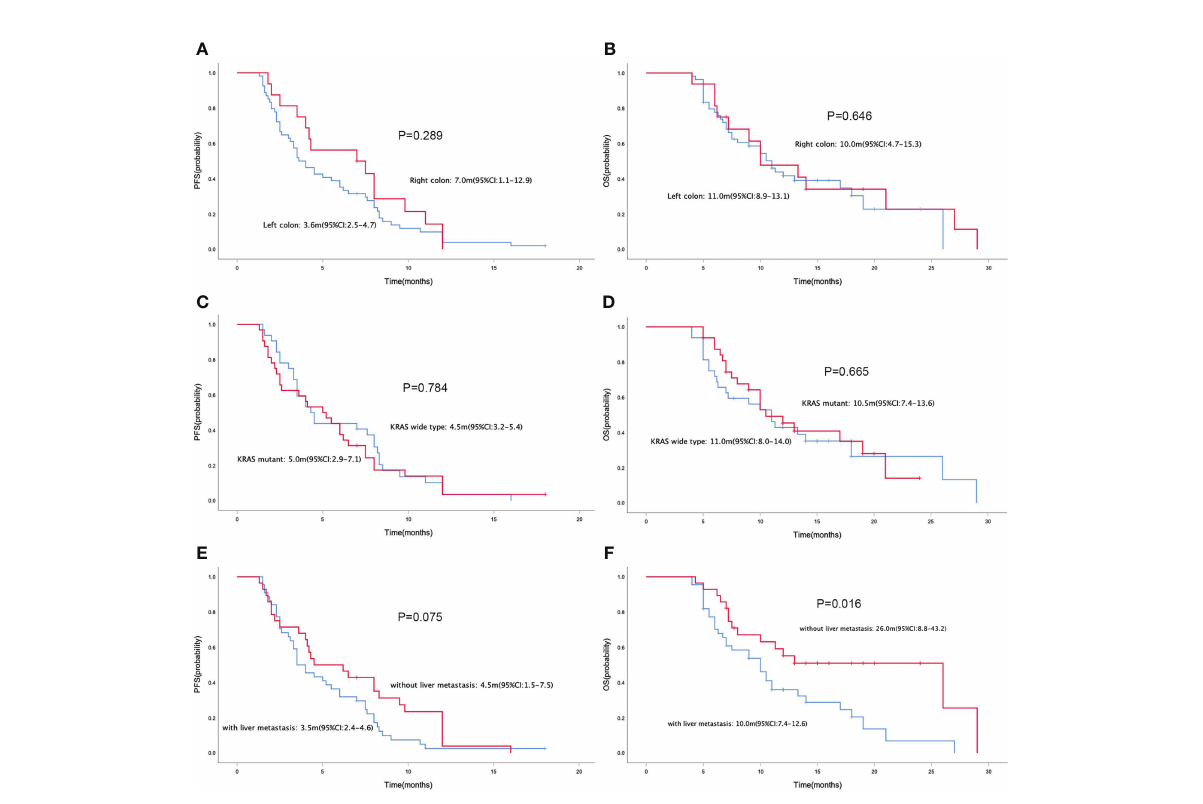
FIGURE 2 Kaplan-Meier curve of PFS (A) and OS (B) in patients with different primary tumor site (left colon vs. right colon). Kaplan-Meier curve of PFS (C) and OS (D) in patients with different KRAS status (wide type vs. mutant). Kaplan-Meier curve of PFS (E) and OS (F) in patients with liver metastasis or without liver